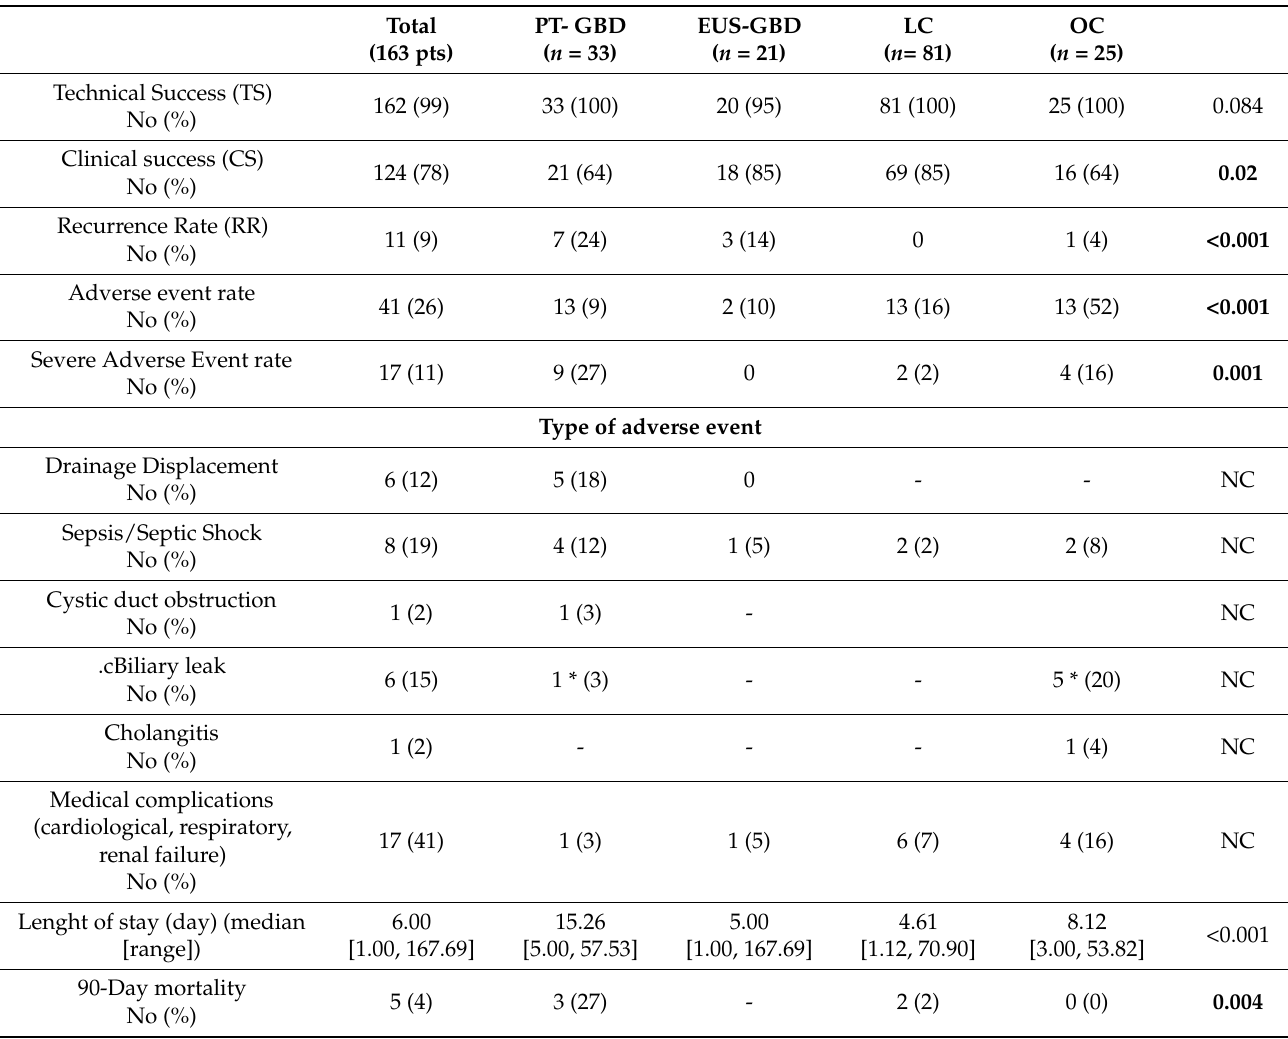
Table 2. Postoperative